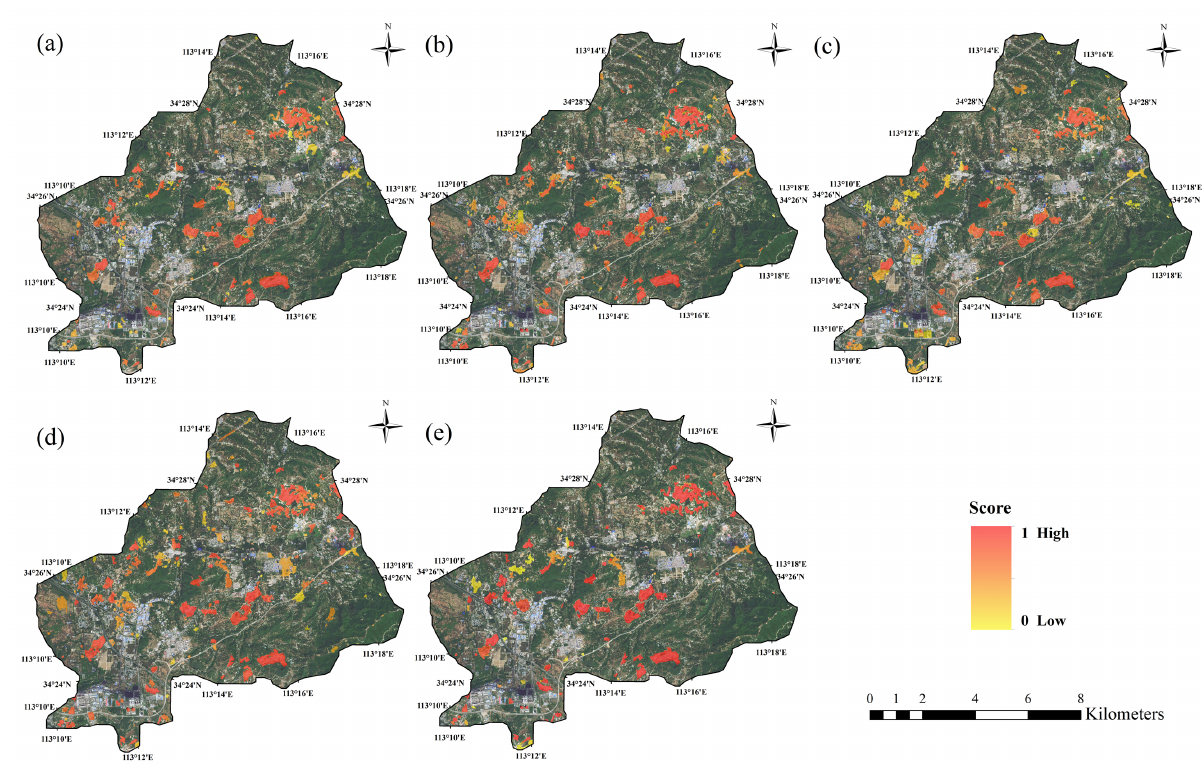
Figure 12. Detection results on Tianditu image in Daye Town. ( a ) Detection result by BlendMask model; ( b ) detection result by BlendMask-VoV model; ( c ) detection result by CondInst model; ( d ) detection result by CondInst-VoV model; ( e ) detection result by Mask R-CNN